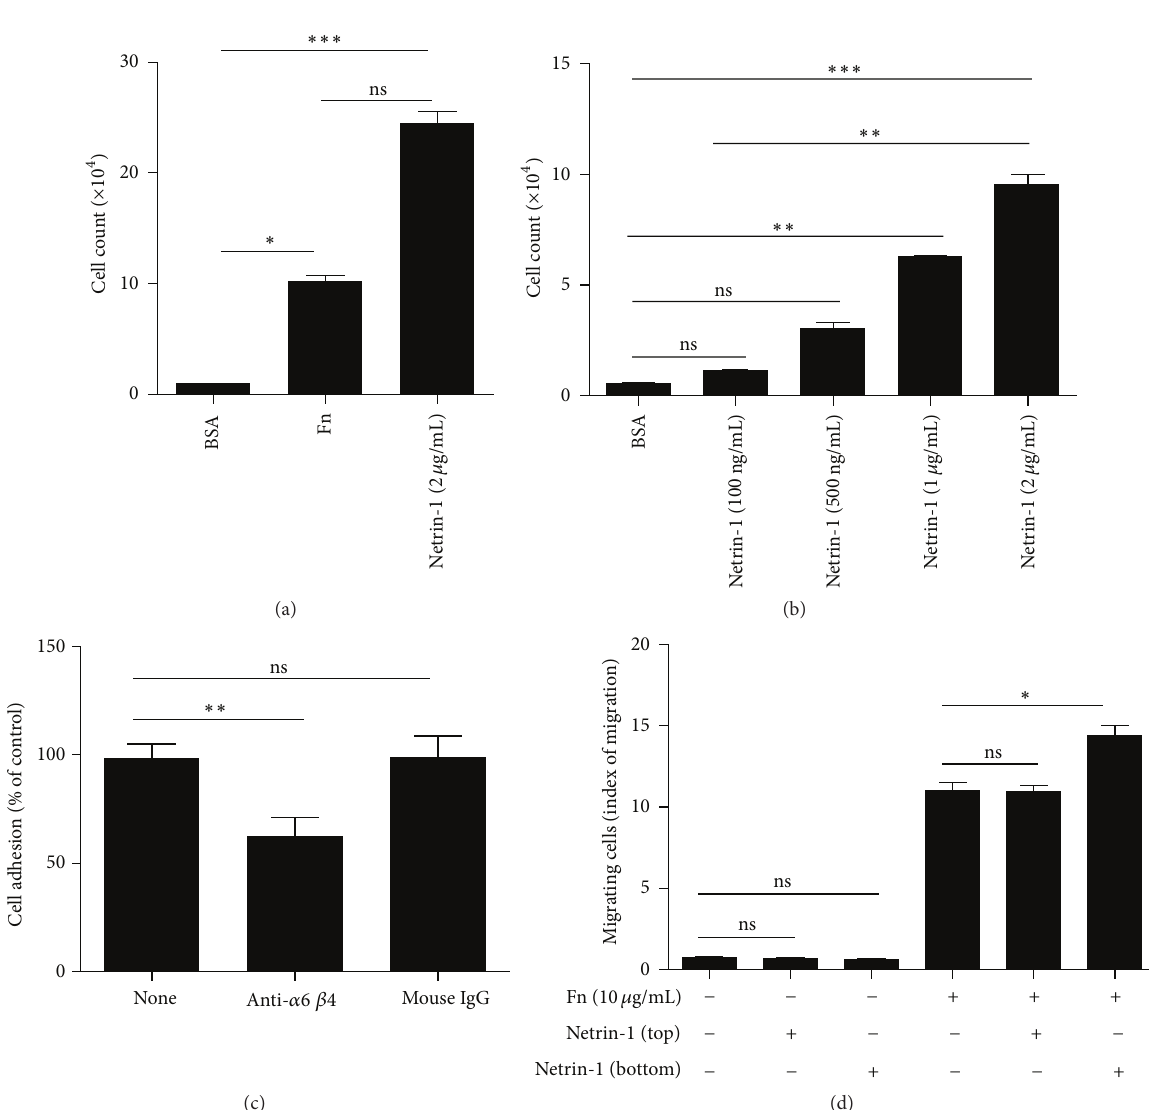
Figure 3: Adhesive effect of Netrin-1 on thymocytes. (a) Quantification of thymocyte adhesion to plate coated with BSA, fibronectin (Fn), or Netrin-1. (b) The inserts of Transwell were coated with different concentrations of Netrin-1, and thymocytes were plated in the upper chamber of Transwell. Histograms represent the number of migrating thymocytes recovered in the lower chamber. (c) Thymocytes were incubated with the function-blocking anti-integrin antibody for 30 min prior to plating on Netrin-1. Cells were allowed to attach for 30 min, then washed, and quantified as described in Materials and Methods. (d) In the presence of Netrin-1 (500 ng/mL), thymocytes were plated in the upper chamber of Transwell under cell migration driven by fibronectin (10 𝜇 g/mL). Histograms represent the number of migrating thymocytes in the lower chamber. Data shown in each image are representative of three independent experiments. ns: not significant; ∗ 𝑃 < 0.05 ; ∗∗ 𝑃 < 0.01 ; ∗∗∗ 𝑃 < 0.001